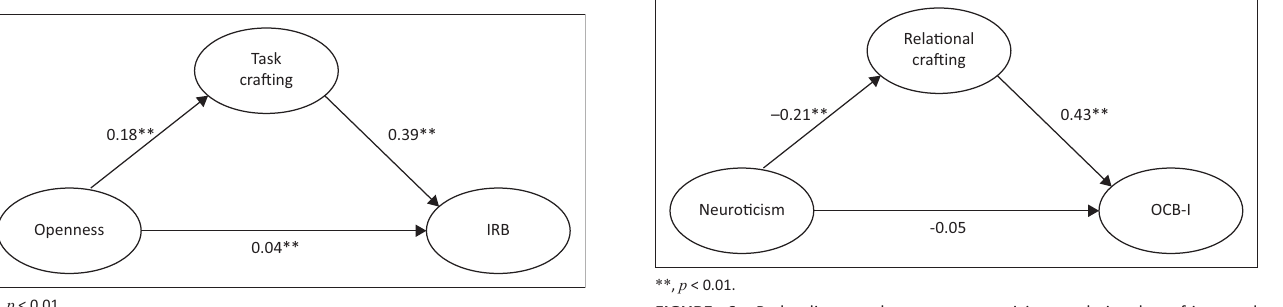
FIGURE 6: Path diagram between neuroticism, relational crafting and organisational citizenship